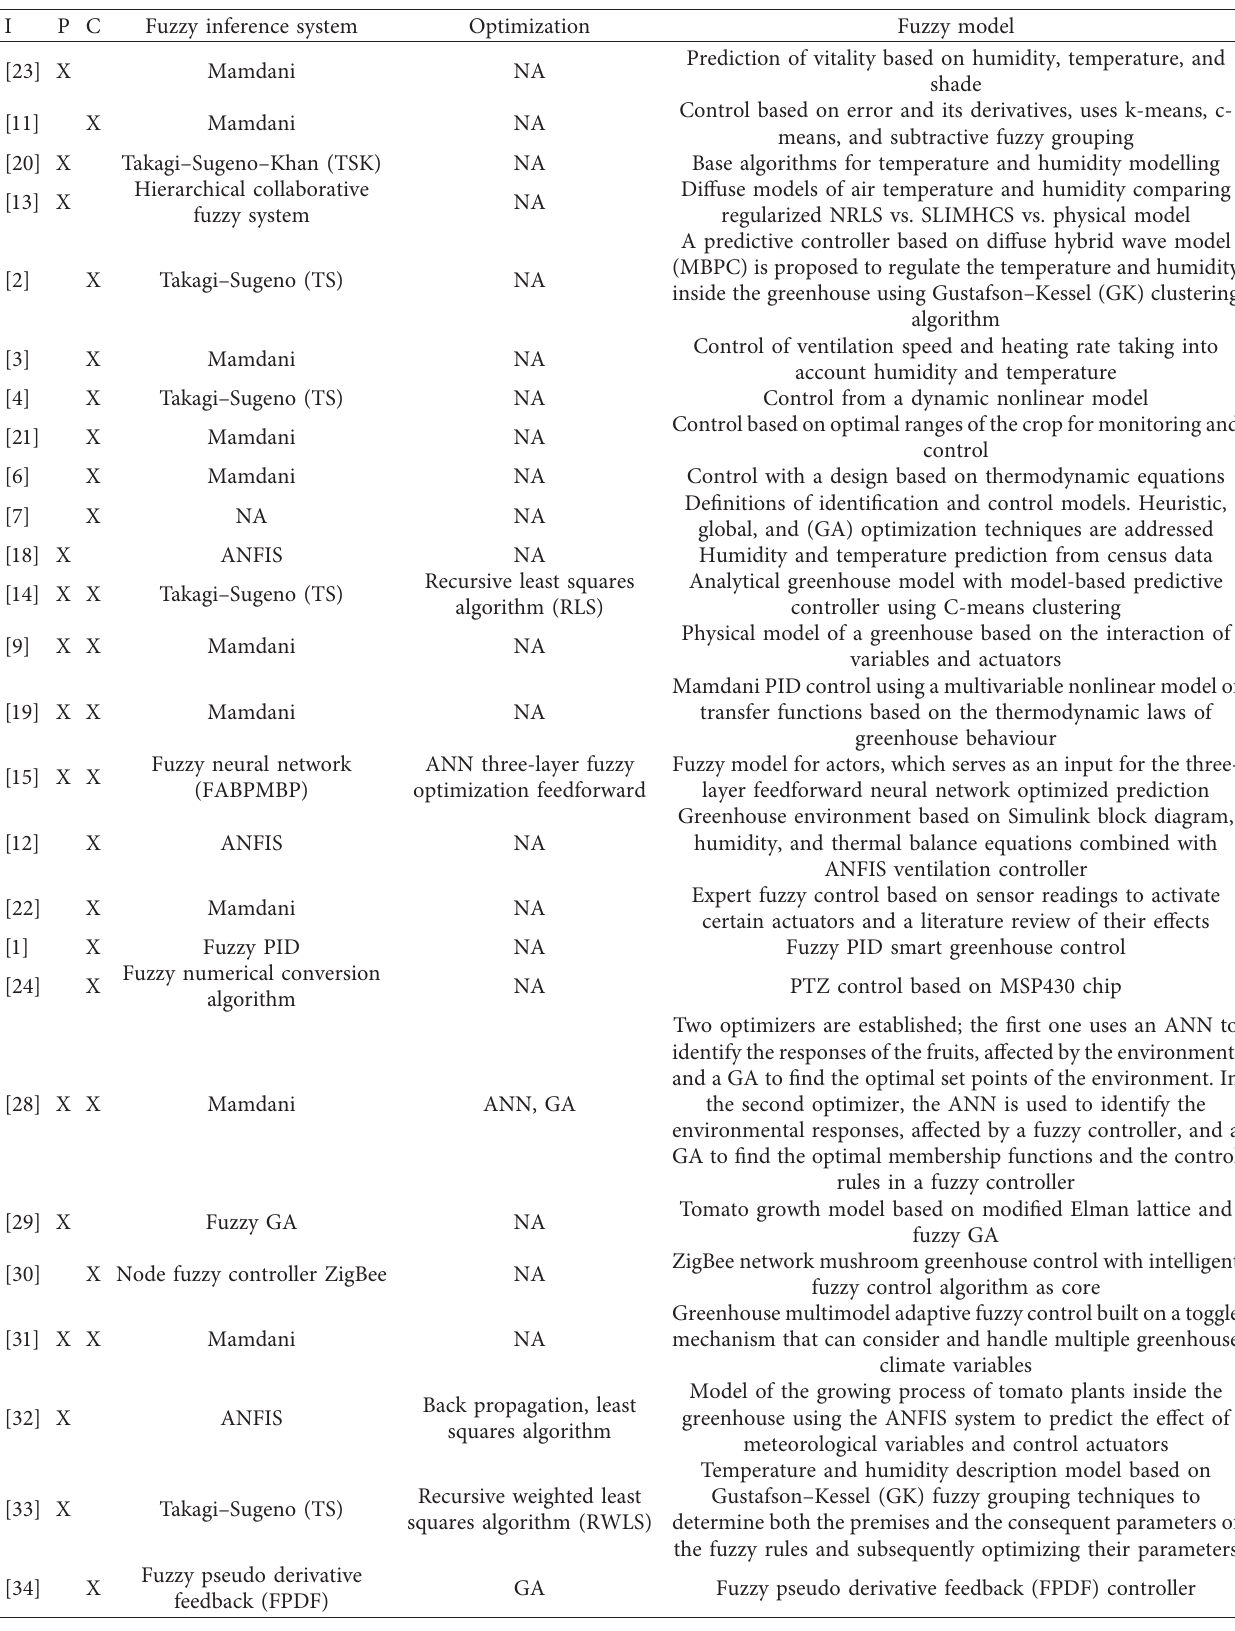
Table 3: Prediction and control models based on fuzzy